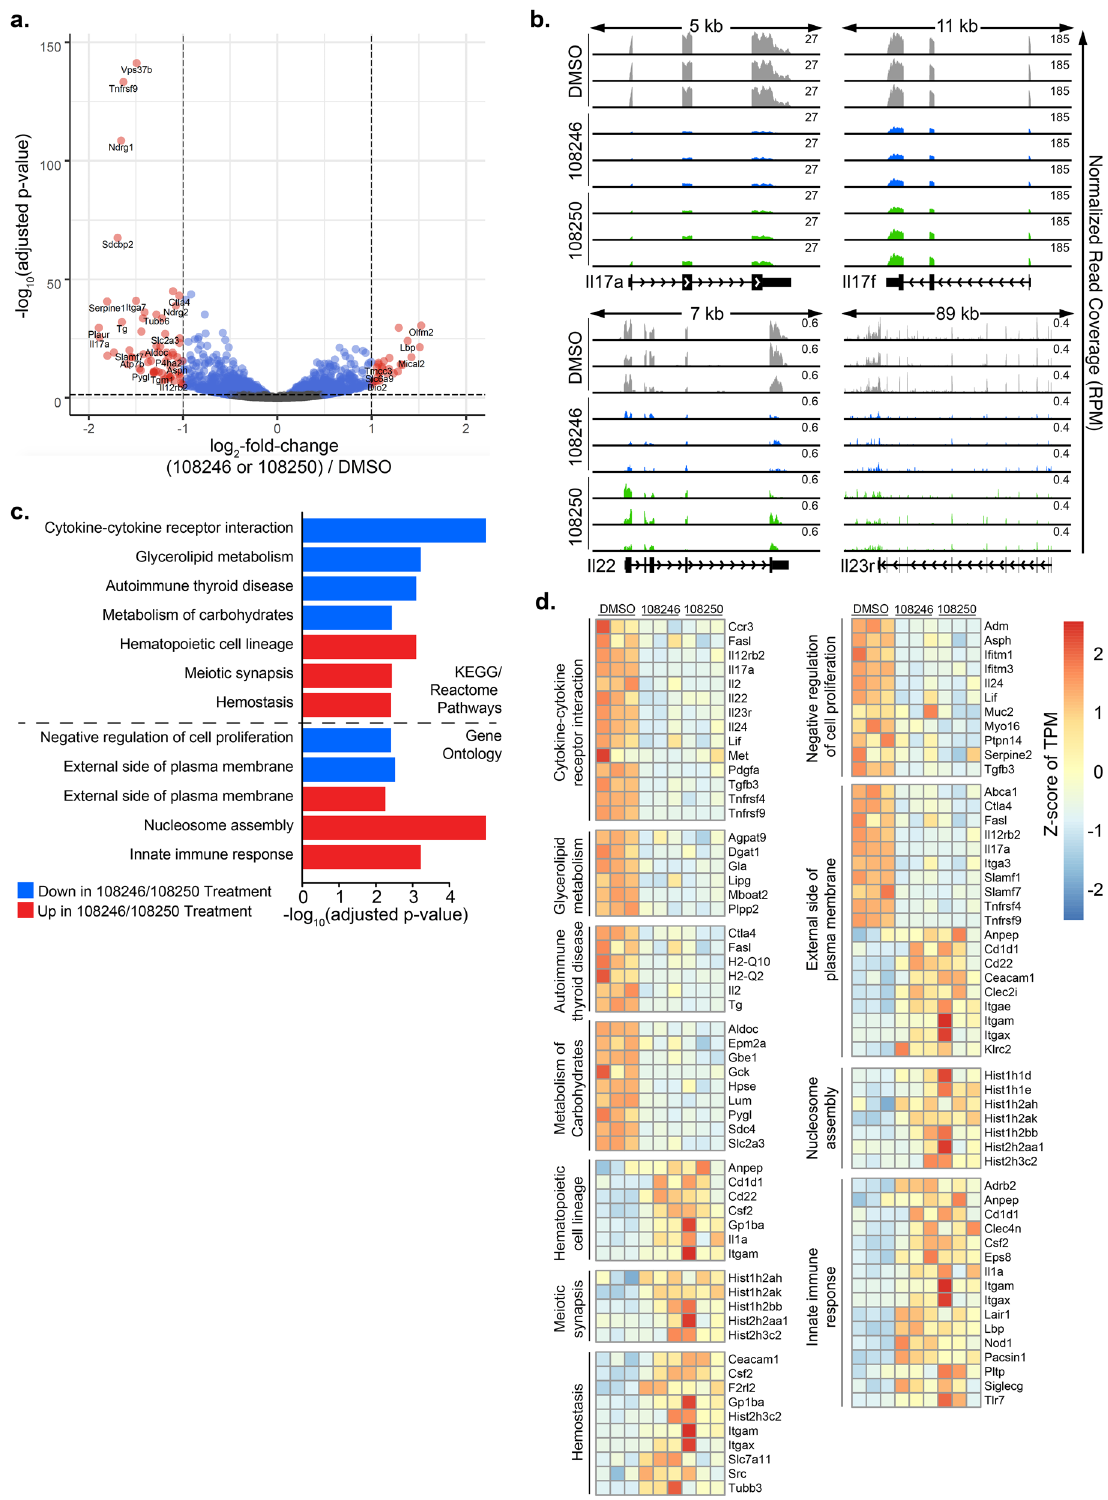
Figure 4. Transcriptomic analysis of Th17 cells on treatment with ‘Imidazoles’. CD4 + T cells were differentiated under Th17 polarization conditions and were either treated with DMSO (control) or NCGC00108246 or NCGC00108250 at 20 µM (representative imidazoles). Differential expression results are shown when comparing the NCGC00108246- or NCGC00108250-treated samples (n = 6) to DMSO (control, n = 3). ( a ) Volcano plot showing differentially expressed transcripts on treatment with (NCGC00108246 or NCGC00108250)/DMSO. ( b ) Genomic browser screenshots of IL-17a , IL-17f., IL-22 and IL-23r loci depicting normalized RNA-seq read coverage (RPM) in Th17 cells treated with DMSO or NCGC00108246 or NCGC00108250 for 24 h. ( c )Bar plots showing negative log 10 P-values of the most enriched pathways from the KEGG and Gene Ontology databases, as calculated by InnateDB using 2328 differentially expressed genes between (NCGC00108246 or NCGC00108250) and DMSO RNA-seq as input. ( d ) Heat map showing differentially expressed genes in Th17 cells treated with DMSO, NCGC00108246 or NCGC00108250 for 24